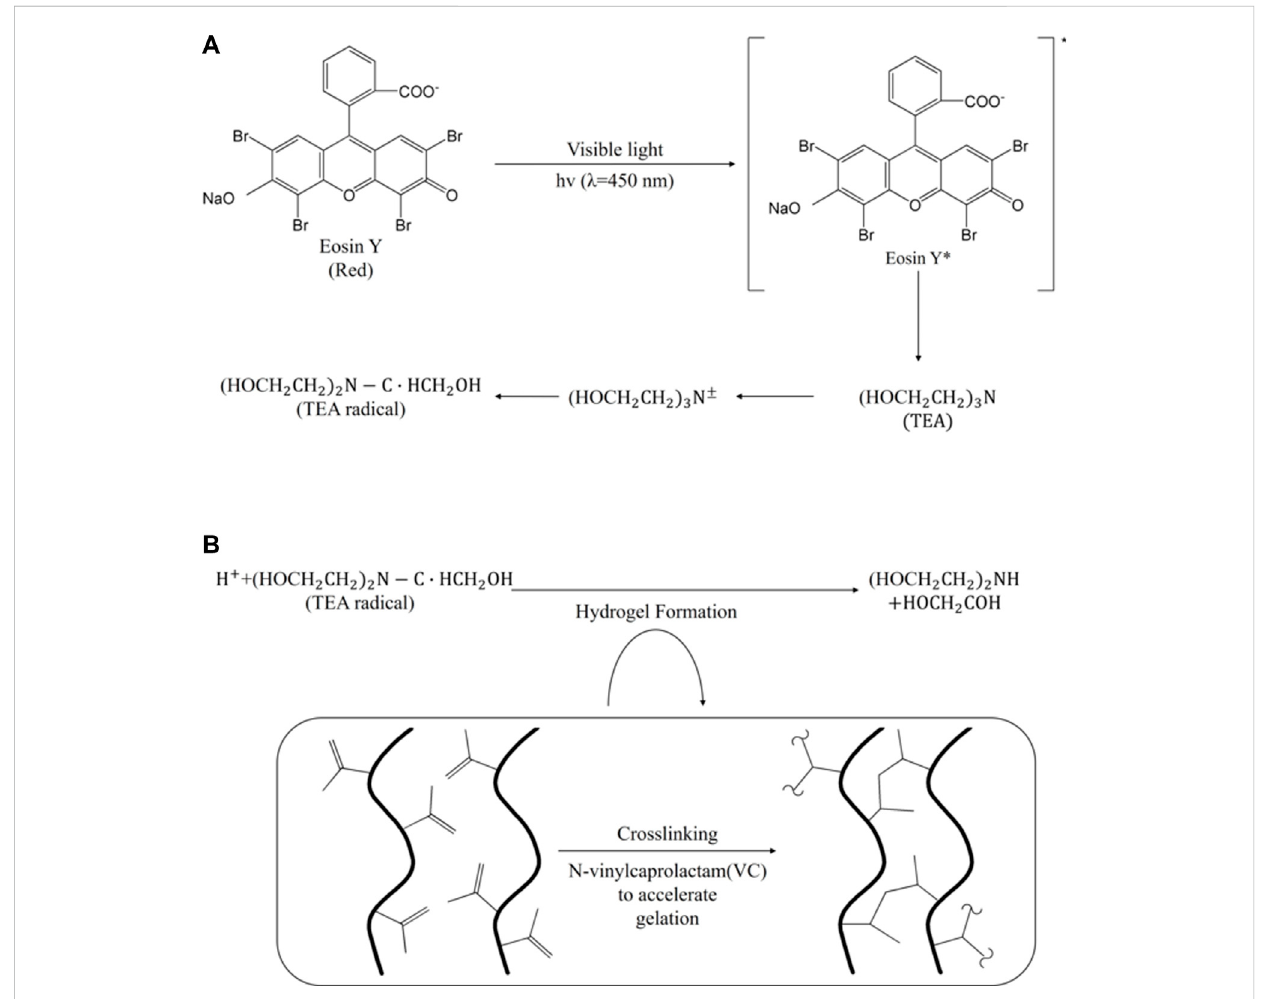
FIGURE 8 The mechanism of (A) eosin-based photopolymerization and its (B) hydrogel formation (Noshadi et al.,